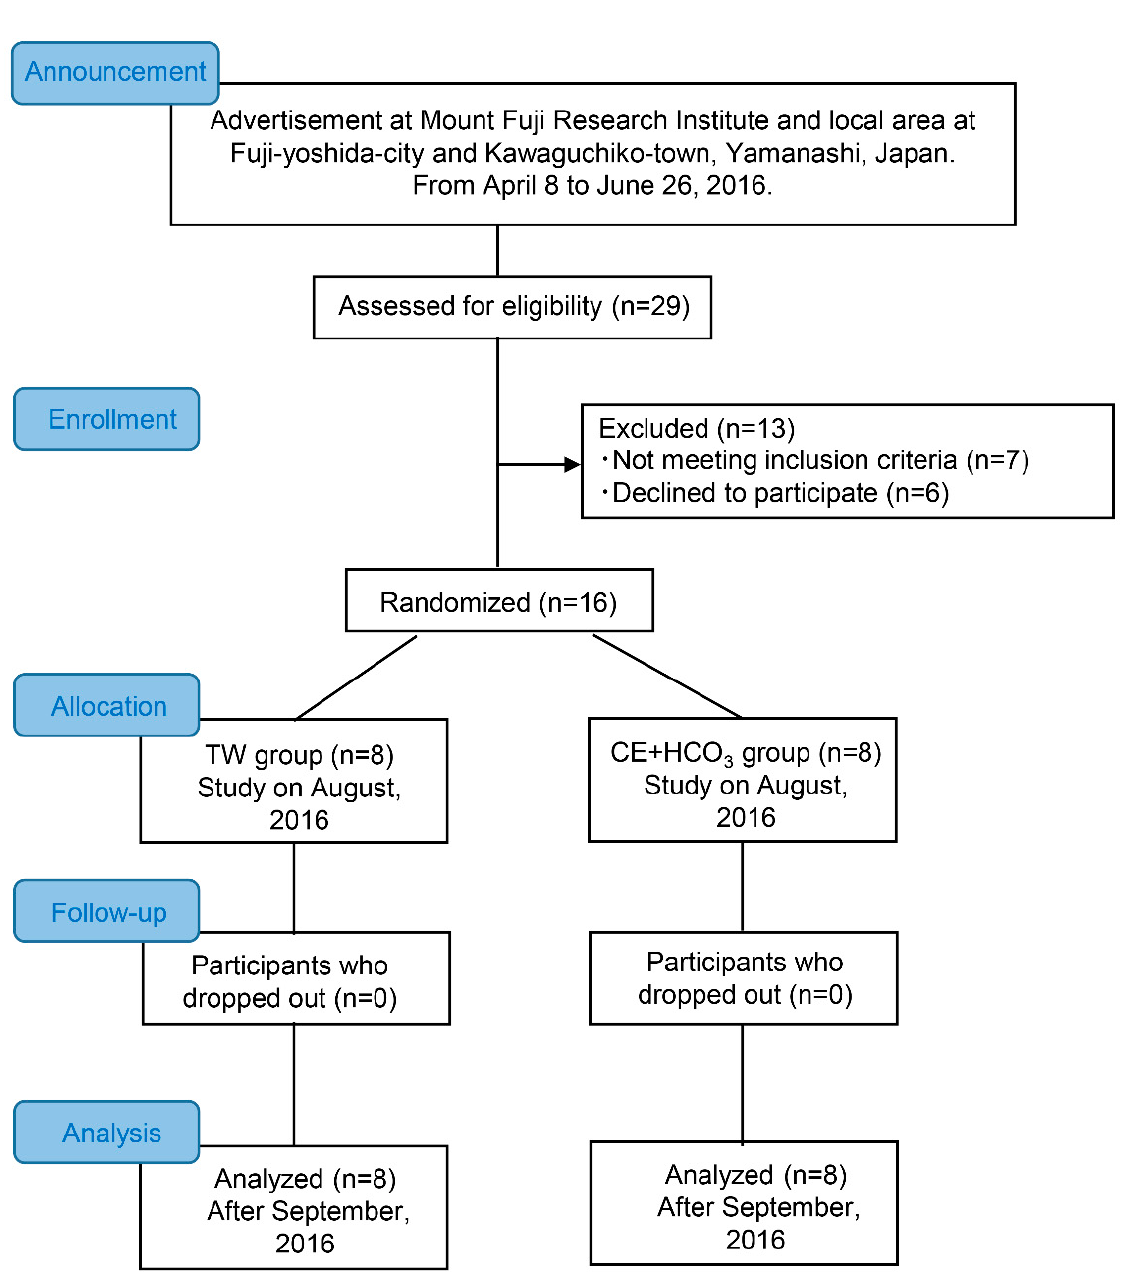
Figure 1. A timeline of the present study. TW, tap water; CE+HCO 3 , carbohydrate solution including bicarbonate ion.